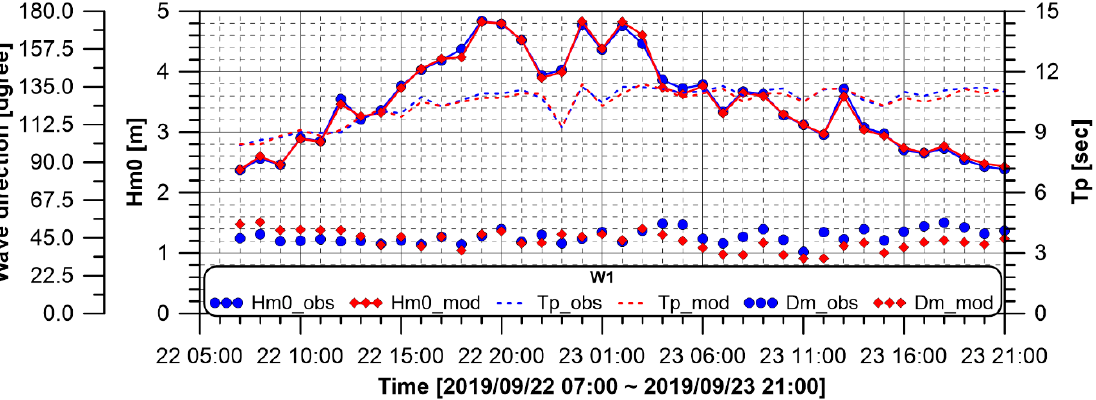
Figure 14. Comparison of wave conditions ( H m 0 , T p , and D p ) between the observational (blue) and modeled (red) data in W1 during the period of the wave event selected for AC from 07:00 on the 22nd to 21:00 on 23 September 2019 (37 h). It is noted that the modeled data matched well with the observational data due to the proximity of W1 to the open boundary, as shown in the computational domain (Figure 4b).